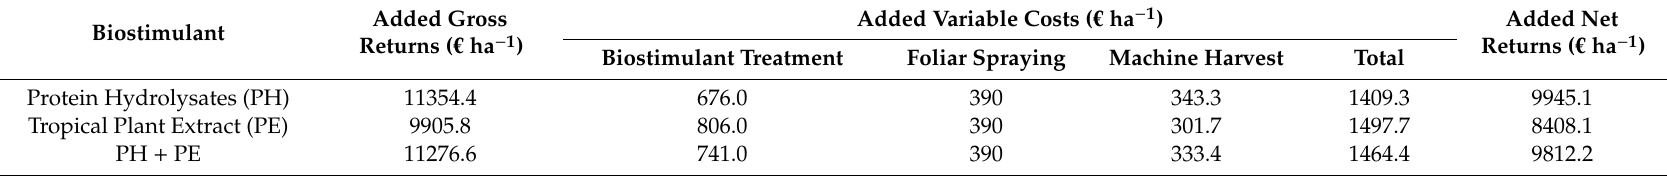
Table 5. Added returns incurred by biostimulant applications under greenhouse conditions compared to untreated